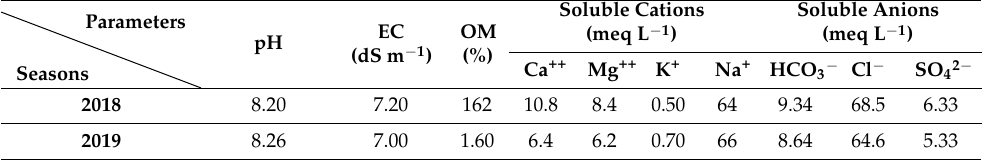
Table 1. Chemical analysis of the experimental soil during the seasons of 2018 and